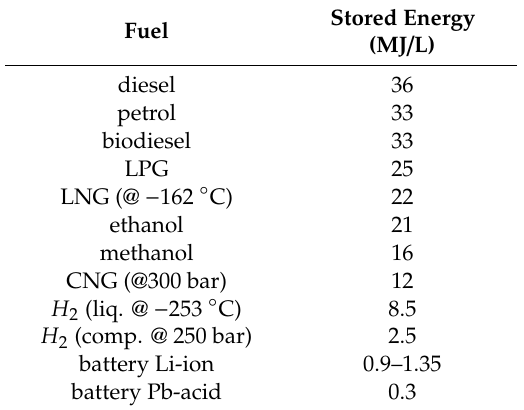
Table 1. Storage energy in volume for fuels and batteries [25].